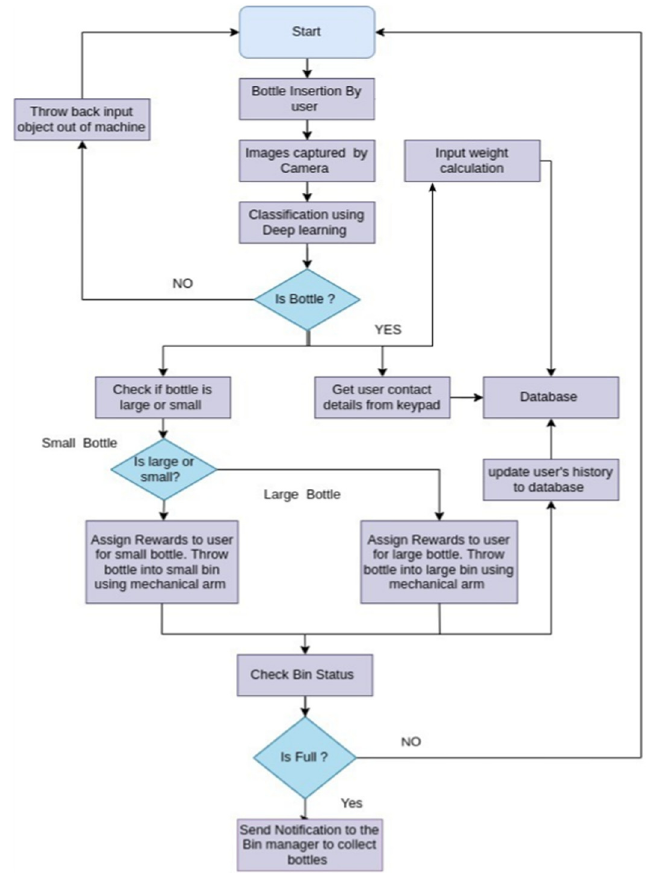
Figure 2. Flow chart of the proposed Reverse Vending Machine.